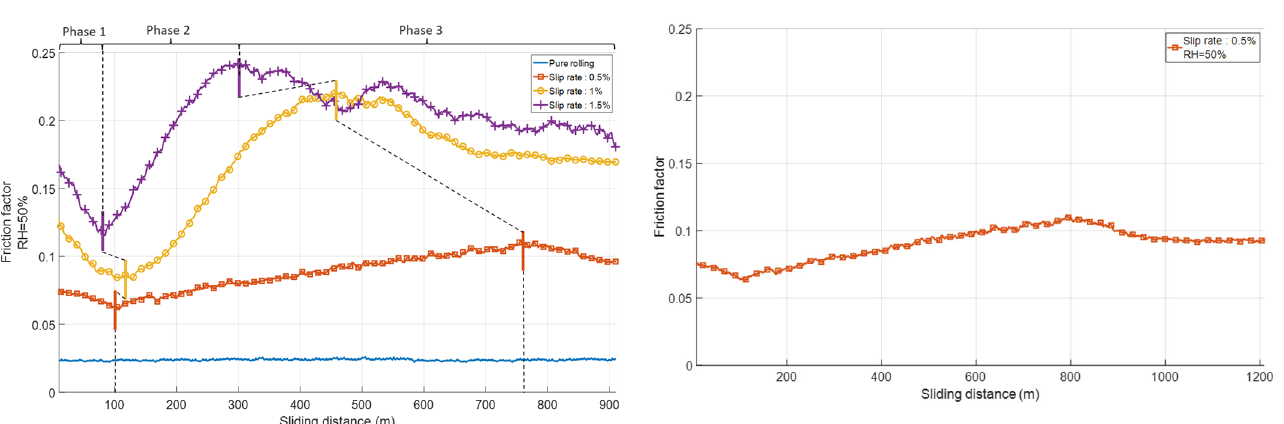
Fig. 13. Friction factor as a function of the sliding distance achieved on Triboring tribometer, plane leaves RH = 50%, slip rate :